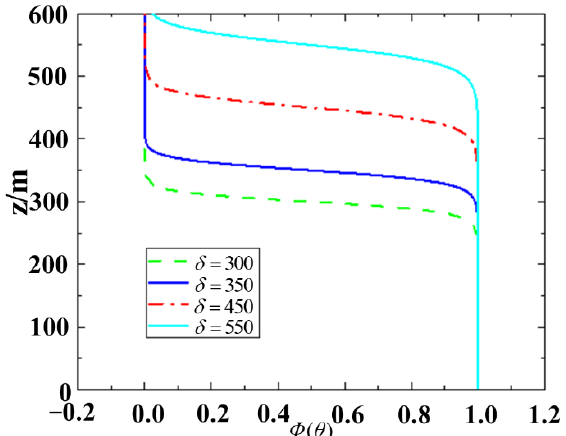
Figure 3. Variation of the weight function with height above ground and atmospheric boundary layer thickness.